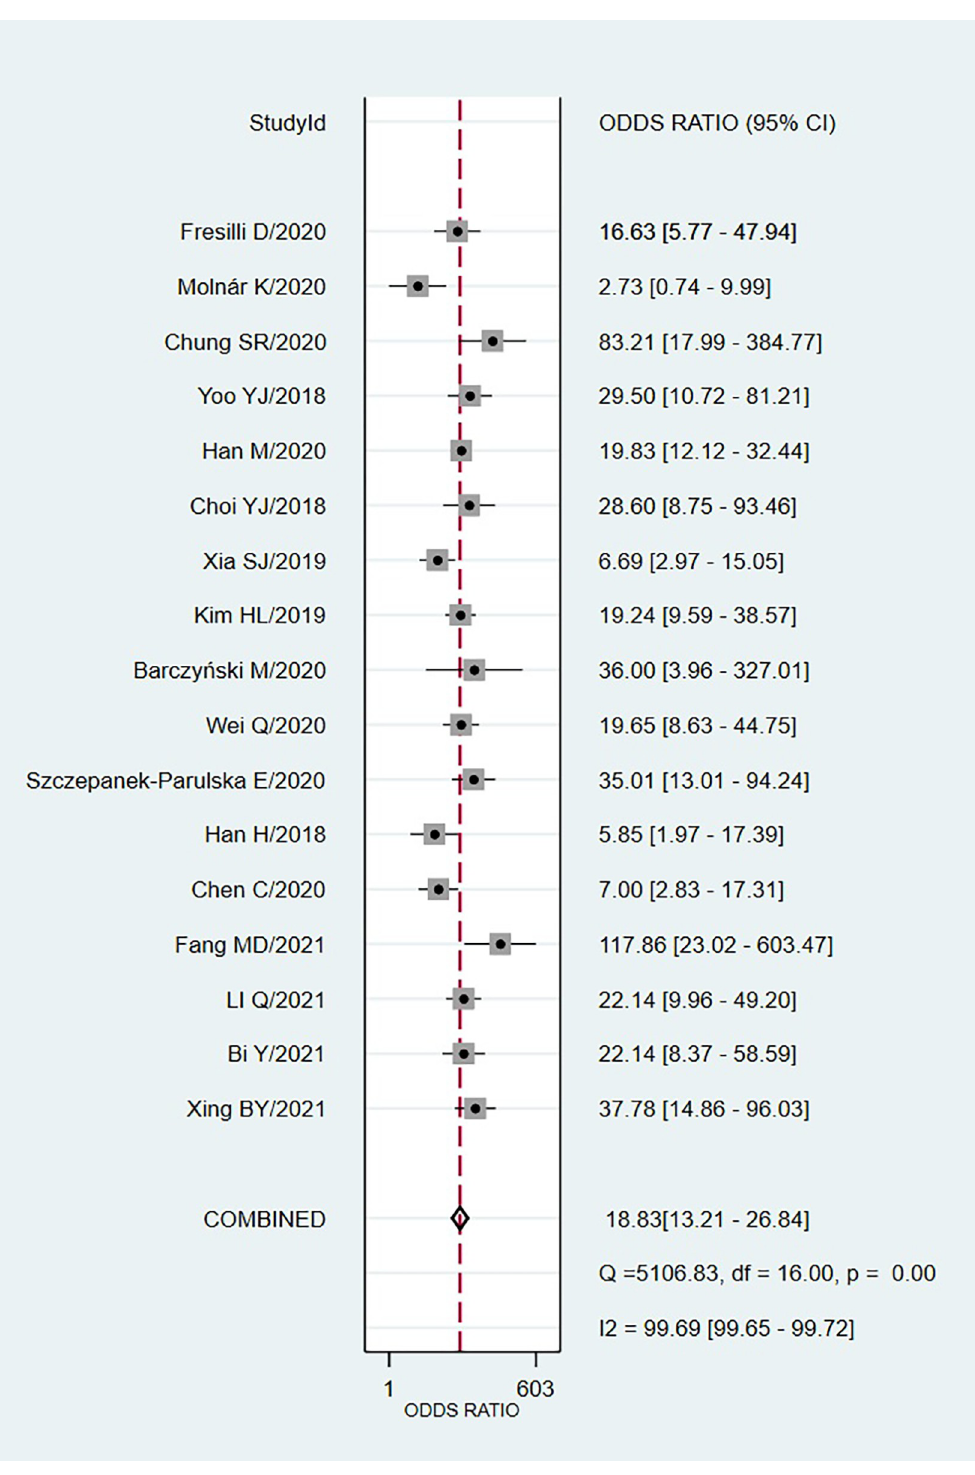
Fig 5. The forest plot results of DOR of S-Detect for diagnosis.